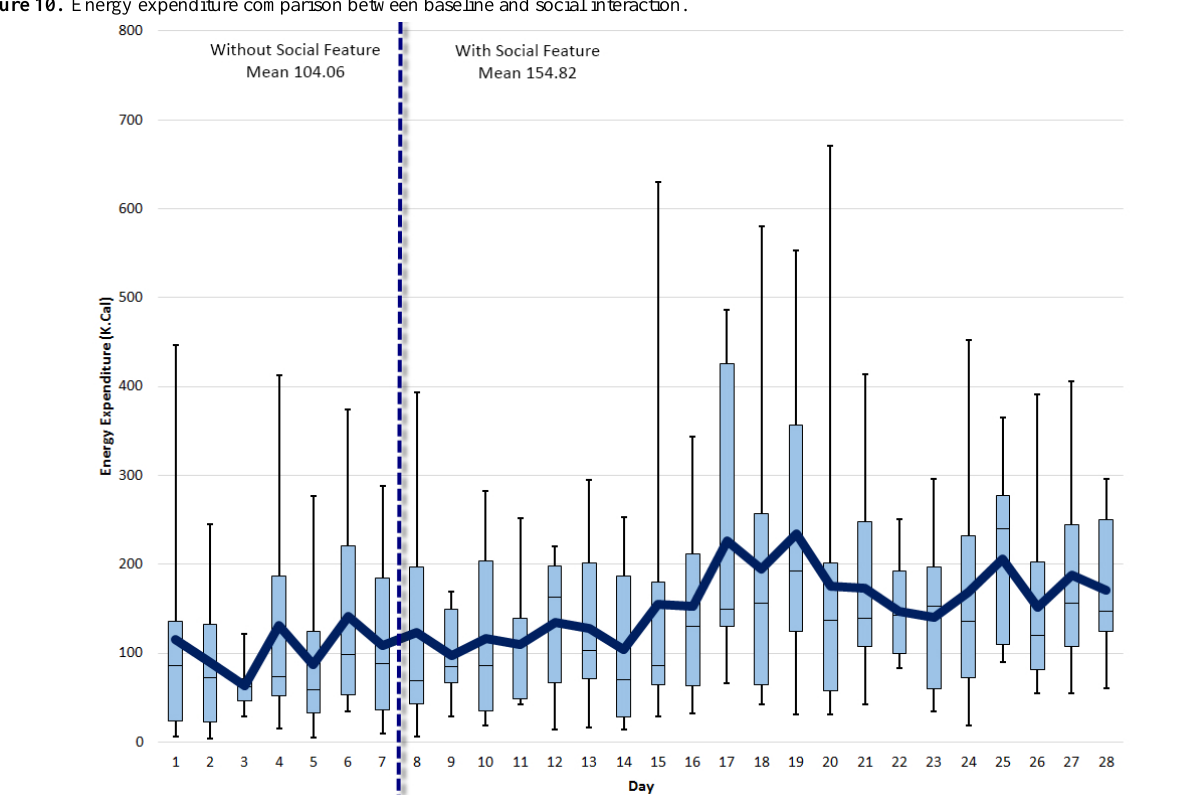
Figure 10. Energy expenditure comparison between baseline and social